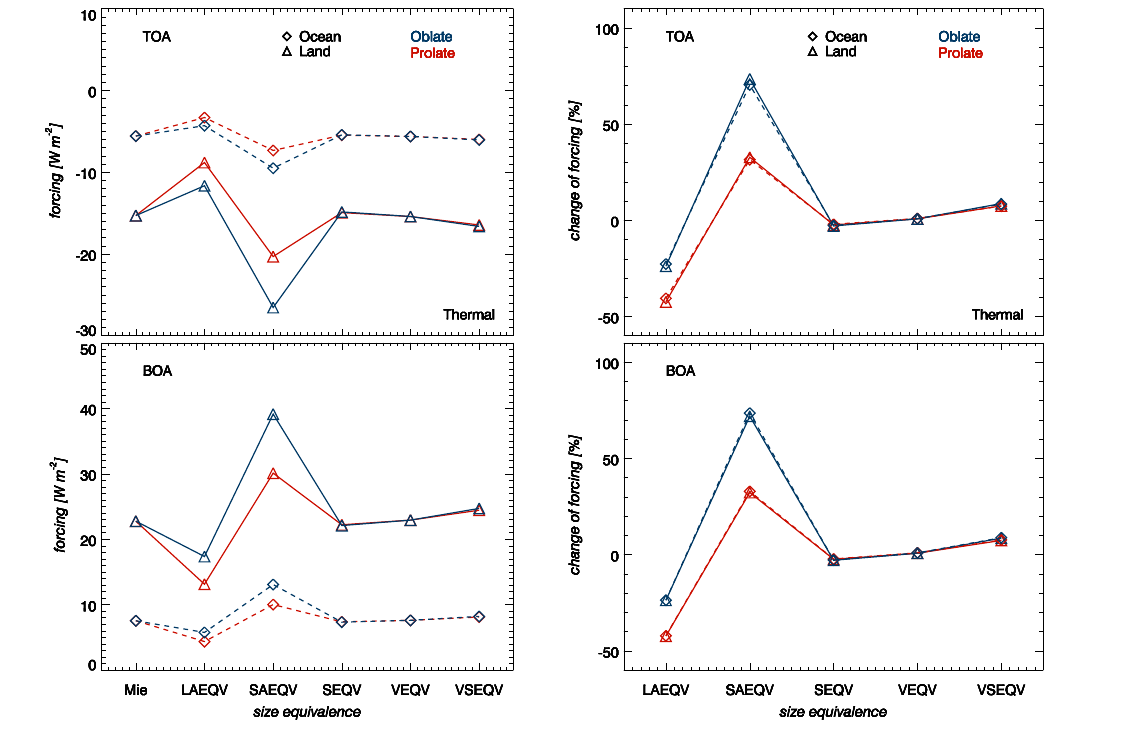
Fig. 16. The same as in Fig. 15, but for thermal spectral